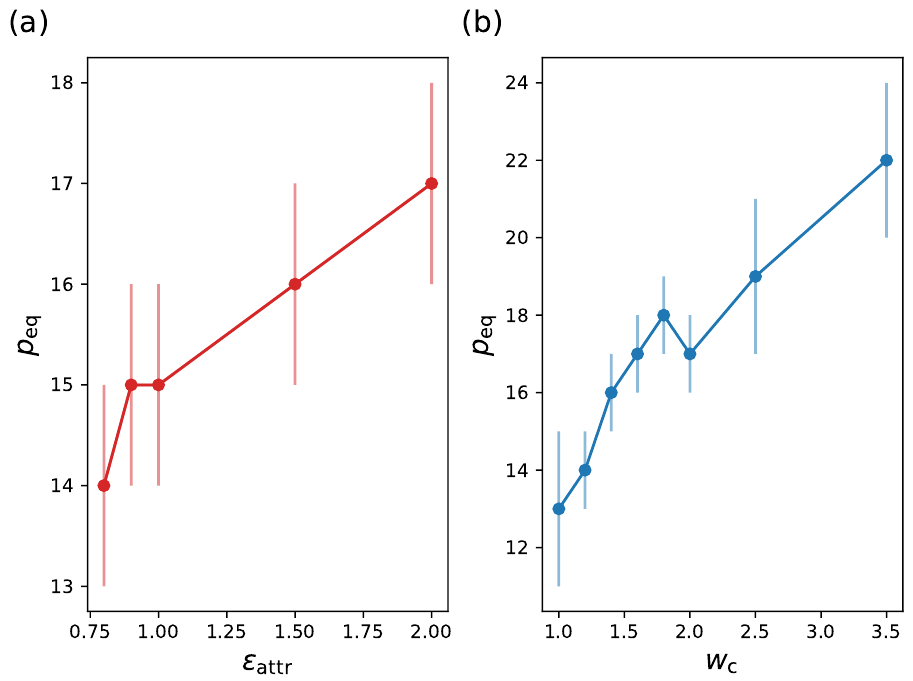
Figure 4. Equilibrium size versus ( a ) (cid:101) attr and versus ( b ) w c . Other system parameters: ( a ) N A = 25, N B = 5 ( g = 0), w c = 1.6 in ( a ), k B T = 1.0, (cid:101) attr = 1.0 in ( b